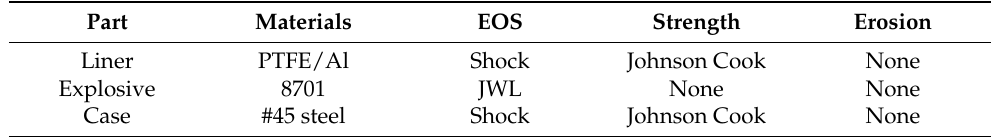
Table 1. Material strength models and EOSs of RLSC.